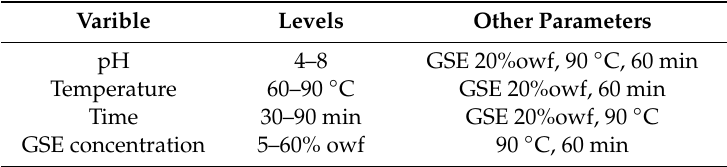
Table 1. Application conditions of grape seed extract